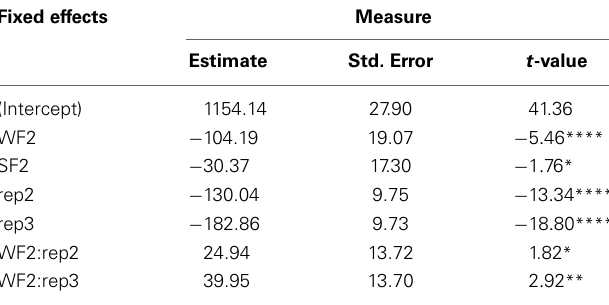
Table 4 | LMM estimates of fixed effects for latencies in